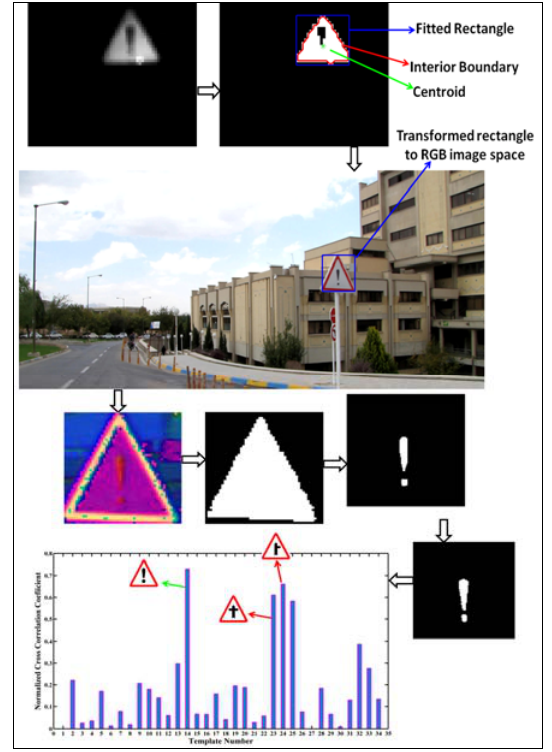
Figure 5. The DRL process applied to a triangular signs